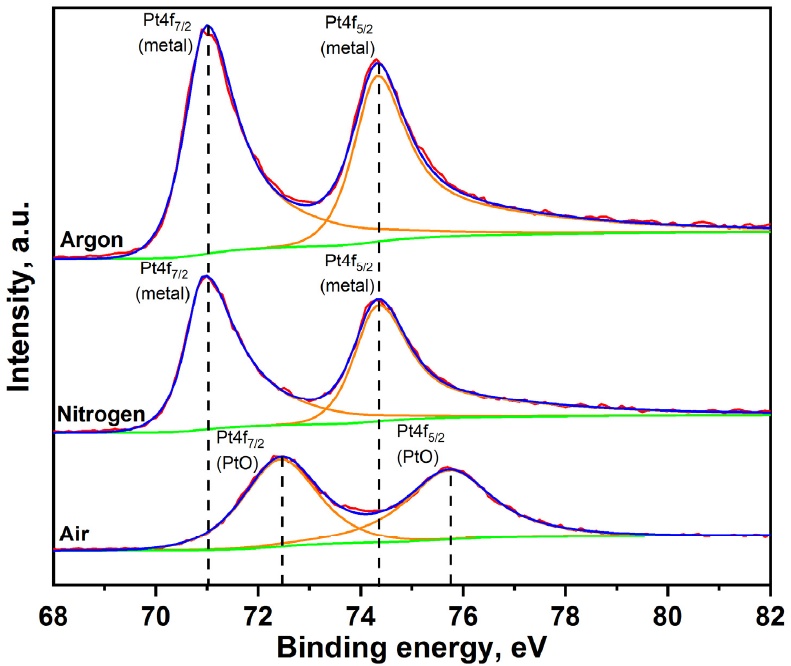
Nanomaterials 2021 , 11 , x FOR PEER REVIEW Figure 6. X-ray photoelectron spectra of PtNPs synthesized by spark discharge under Ar, N 2 and air.